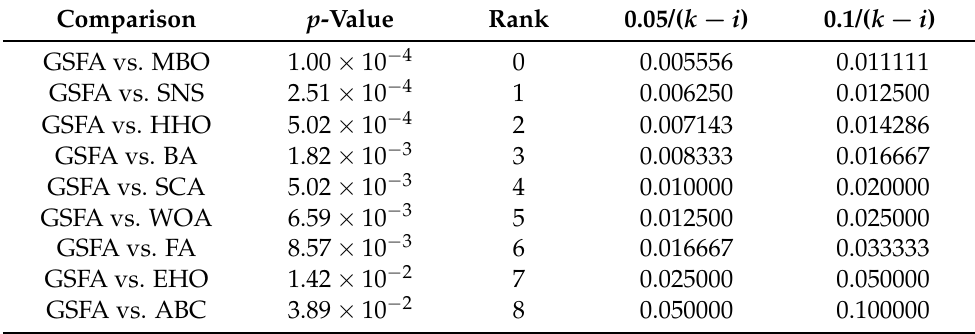
Table 21. Results of the Holm’s step-down procedure.